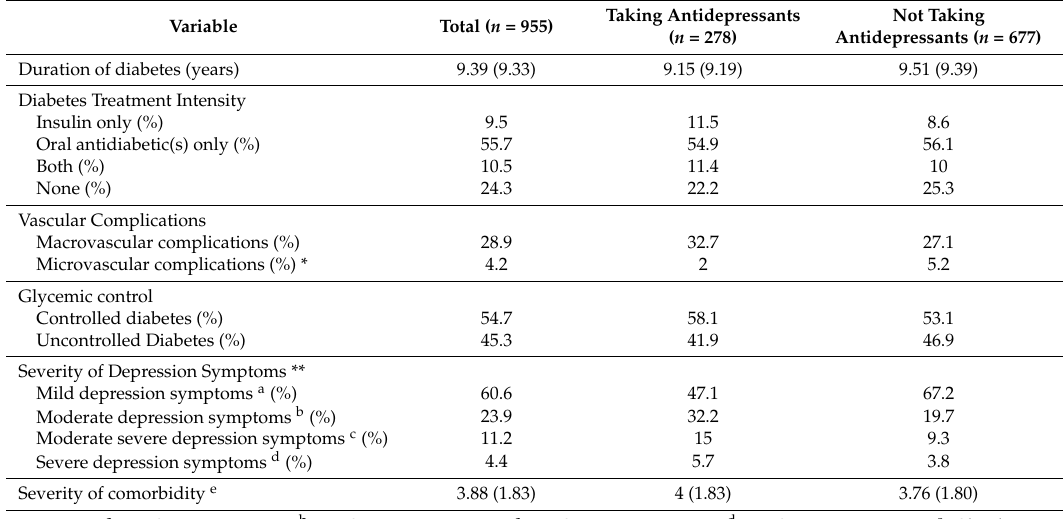
Table 3. Clinical Characteristics of Patients with Type 2 Diabetes and Depression